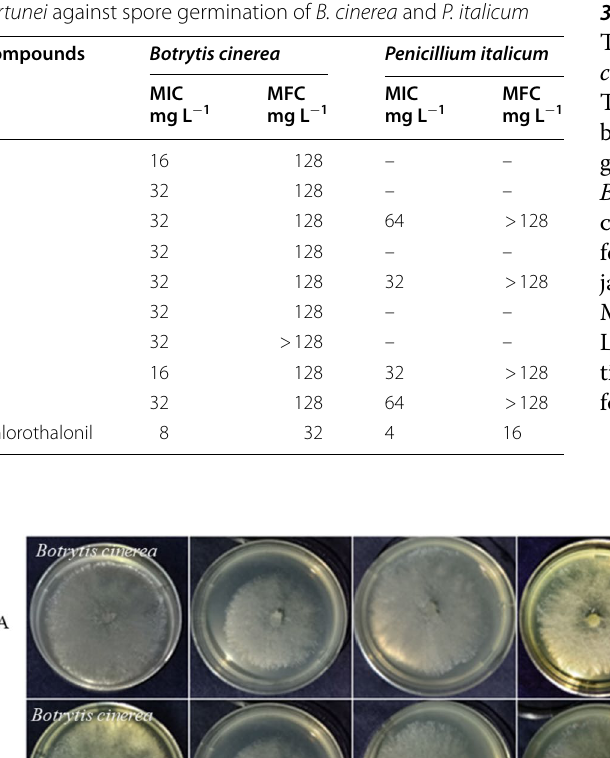
values of the compounds inhibited mycelial growth of B. cinerea 50